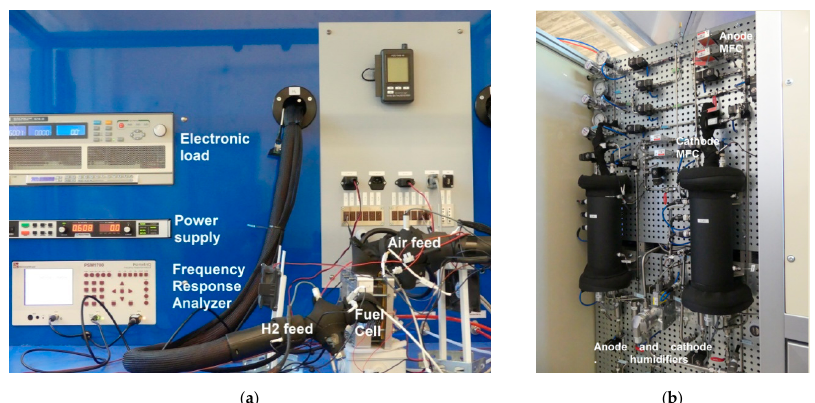
Figure 1. Test bench ( a ) front view showing the main components; and ( b ) back view showing the BoP (Balance of Plant). The fuel cell used in the experiments was a 50 cm 2 single cell from ElectroChem Inc. (Woburn, MA, United States), with graphite bipolar plates featuring a cross-flow serpentine flow field (Figure 2). Vertical channels corresponded to the cathode side and the horizontal channels to the anode side.